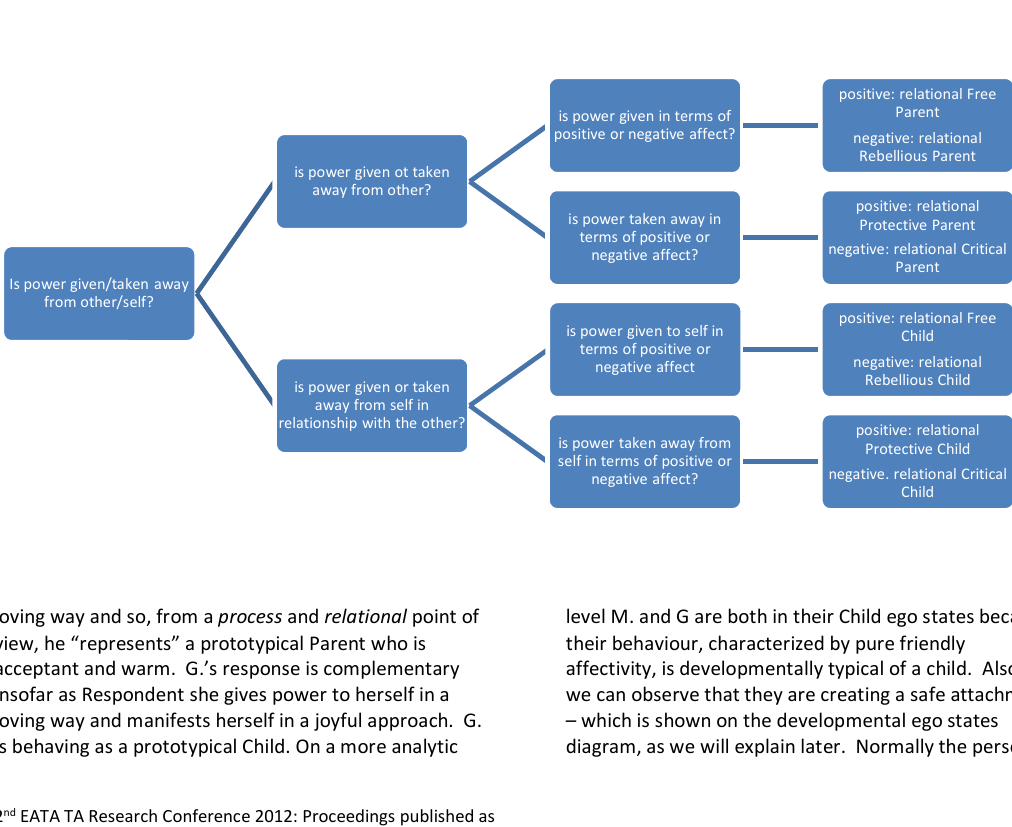
Figure 4 A decision tree to identify the Relational Ego States on the surfaces and within the